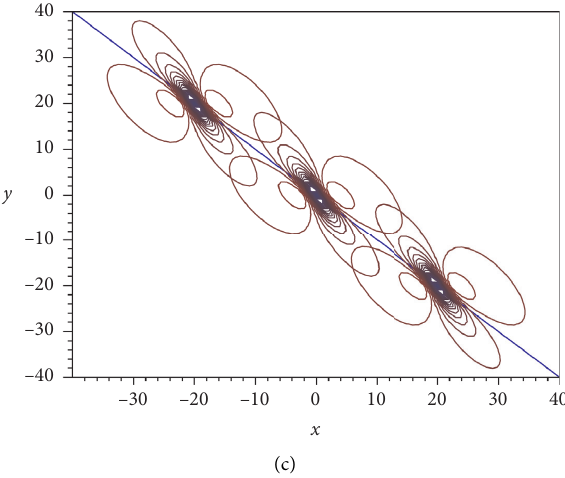
Figure 2: Evolution graphs of the first-order lump solution: (a) three-dimensional plot ( t � 0), (b) density plot ( t � 0), and (c) the contour plot at t � − 10 , 0 , 10 about the moving path described by the blue line.